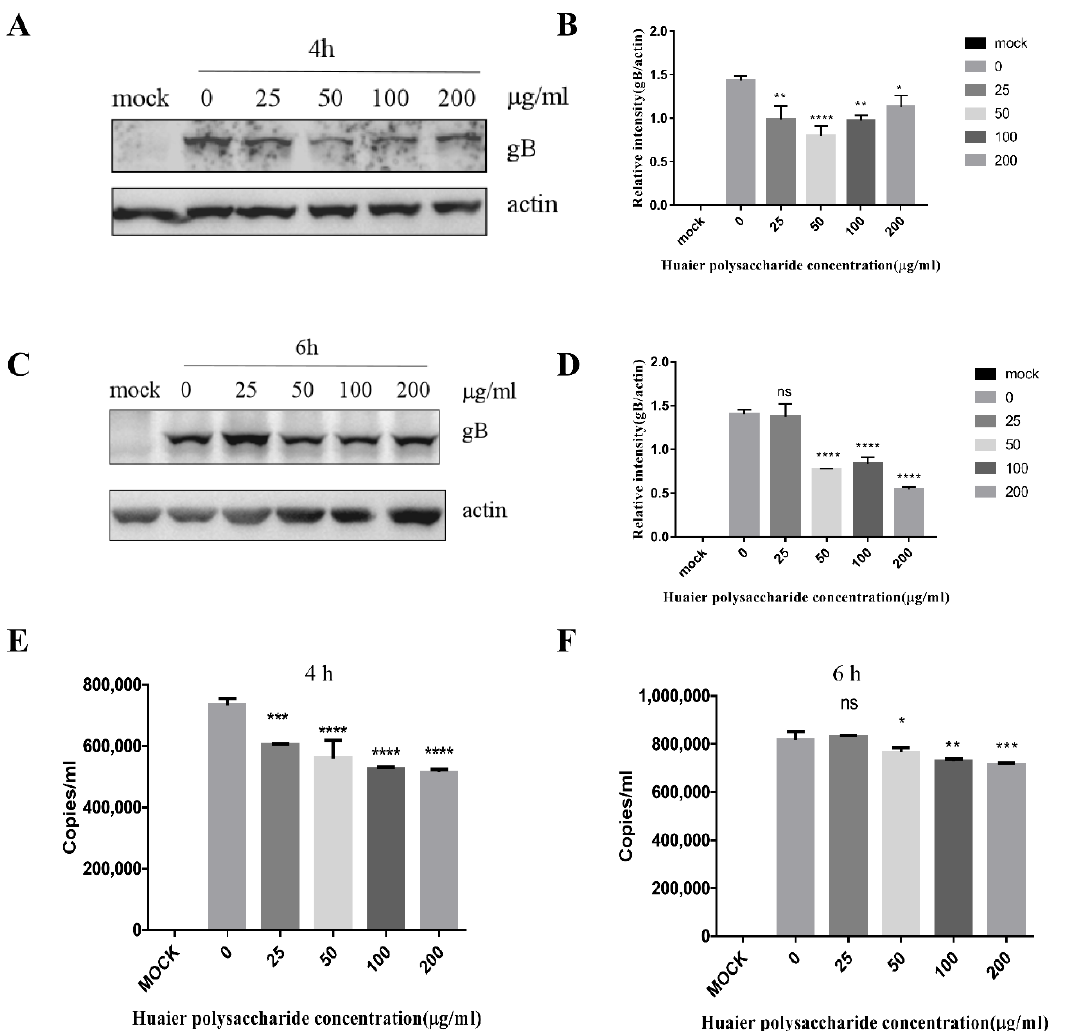
Figure 6. Huaier polysaccharide affects PRV XJ5 replication in PK15 cells. The PK15 cells were treated according to the method described in Section 2.3.6. At 4 and 6 h.p.i., the cells were collected to evaluate the expression of PRV gB and actin proteins through Western blotting ( A , C ). ( B , D ) The relative intensity of intracellular gB to that of actin. The relative intensities of protein were quantified using Image J. ( E , F ) PRV viral DNA copies were analyzed by qRT-PCR at 4 and 6 h.p.i. Significance was analyzed using the one-tailed Student’s t -test. NS, * p = 0.0299, ** p = 0.0017, *** p = 0.0001, **** p < 0.0001. Data are shown as mean ± SD based on three independent experiments.